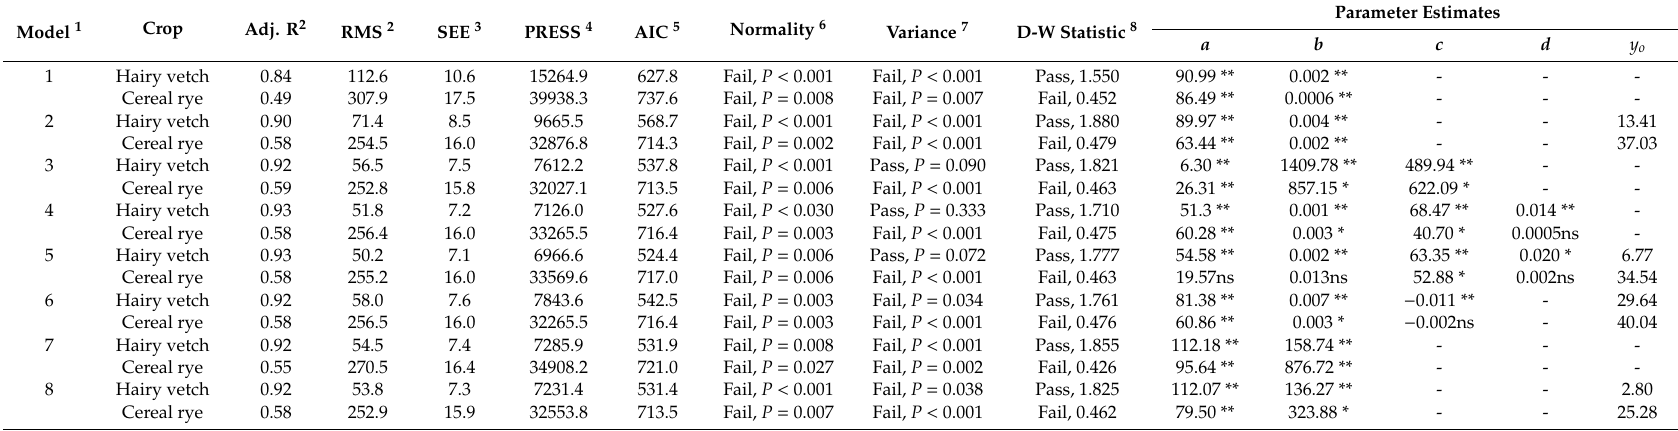
Table 7. Evaluation of models used to describe percent N remaining of aboveground hairy vetch and cereal rye cover crops at Exp. 2 in 2017 and 2018 at Carbondale, IL. Data were pooled across tillage treatments, replicates, and years. Model 1